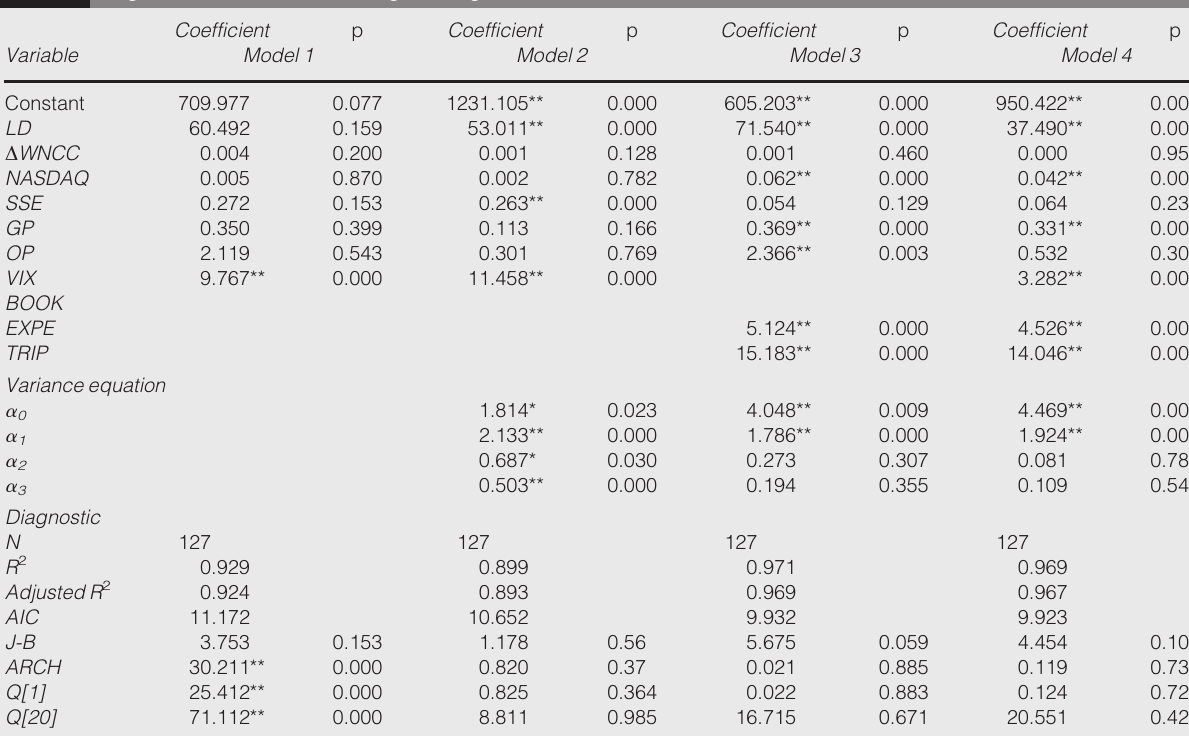
Table 3 Regression results for Booking Holding